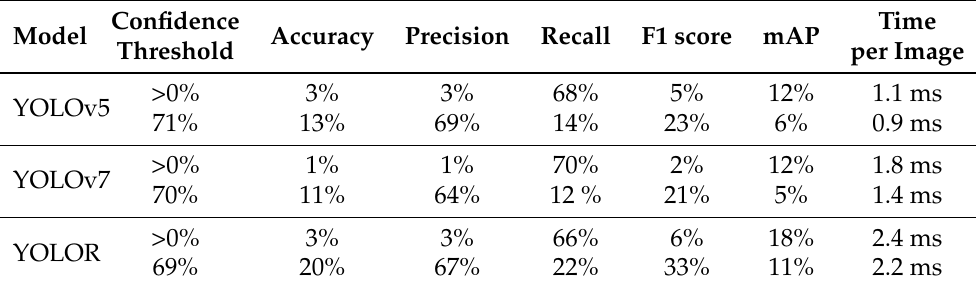
Table 11. Detection results obtained from the TensorFlow Flower Detection Dataset.